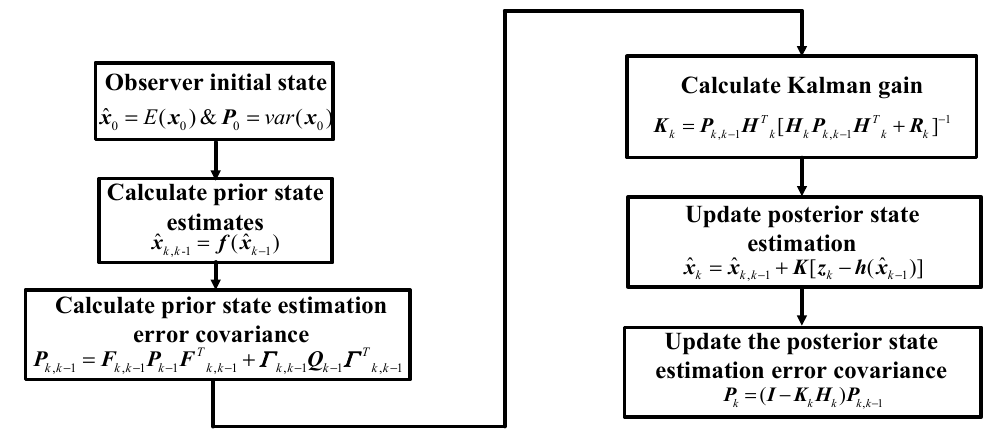
Figure 5. EKF algorithm flow.